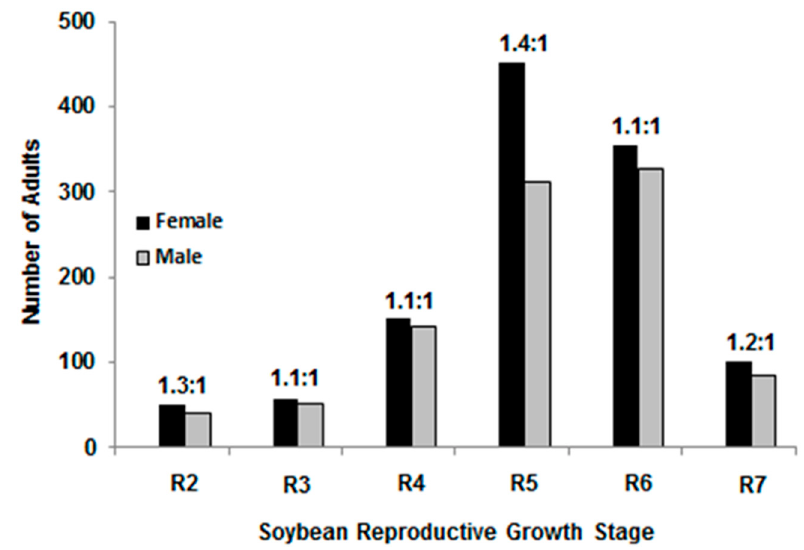
Figure 3. Redbanded stink bug sex ratio during soybean reproductive growth stages.